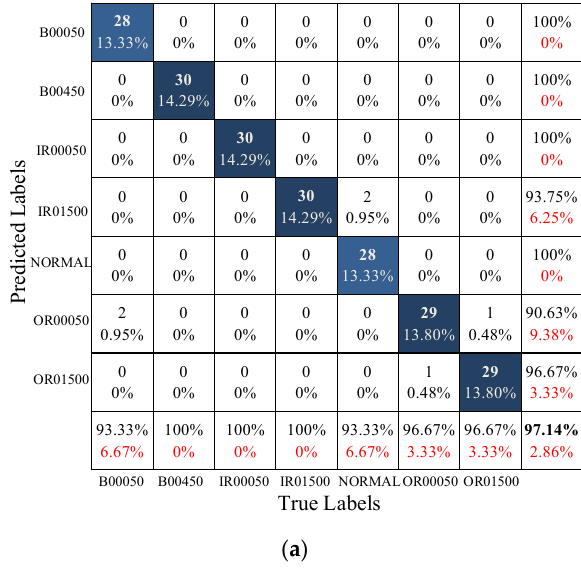
Table 5. Average results for each model.